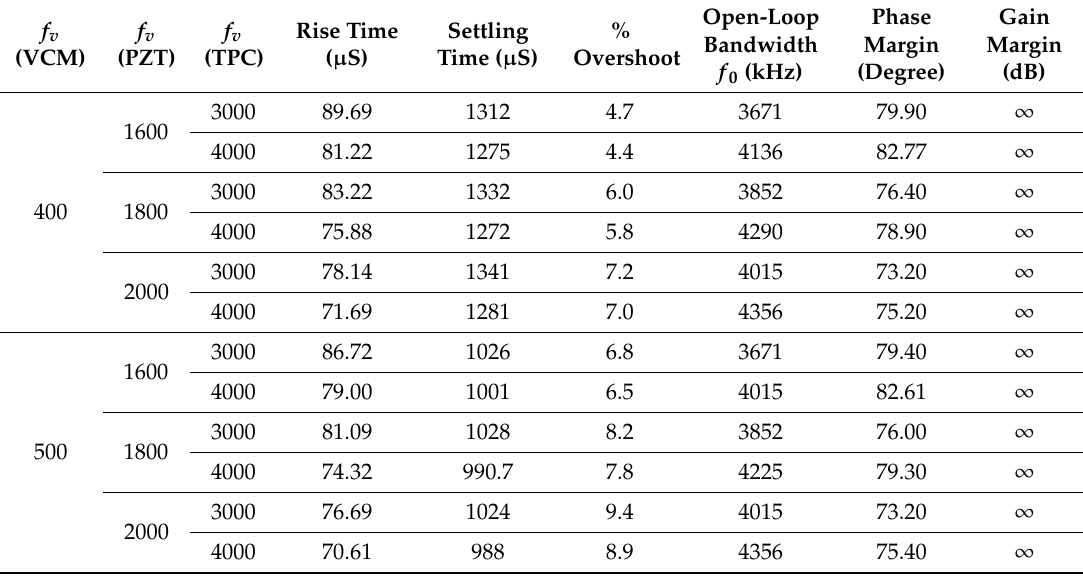
Table 3. Summary for an inverse lead plus proportional plus integral (PI) controller as tertiary controller.